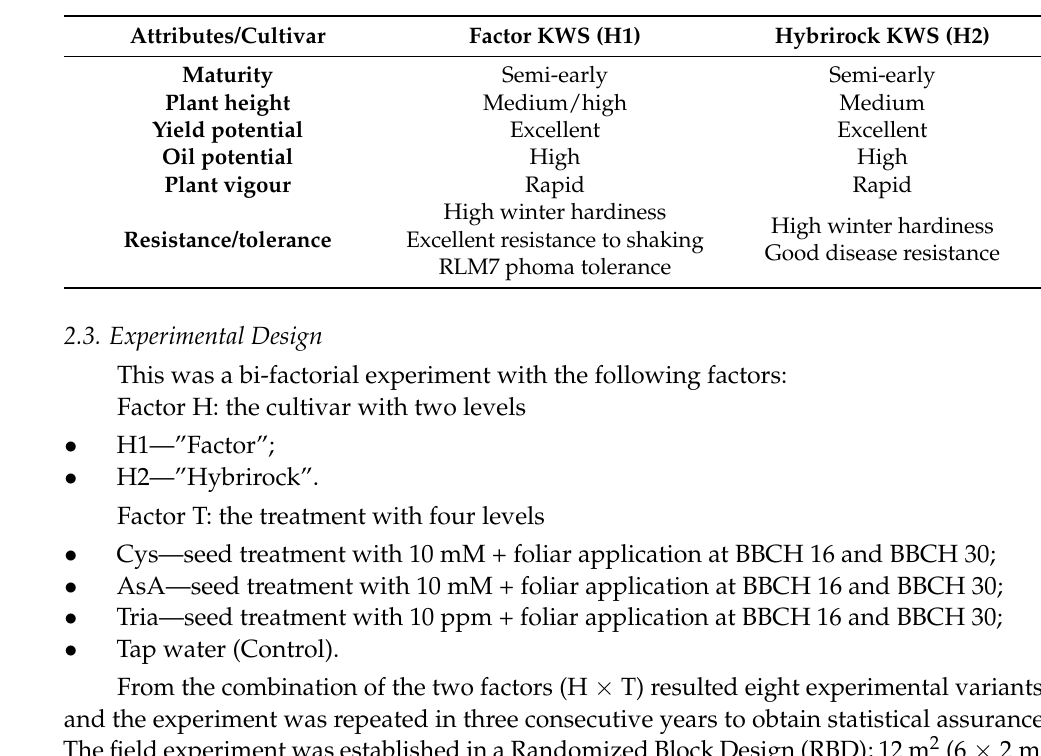
Table 4. Characteristics of canola cultivars [46].